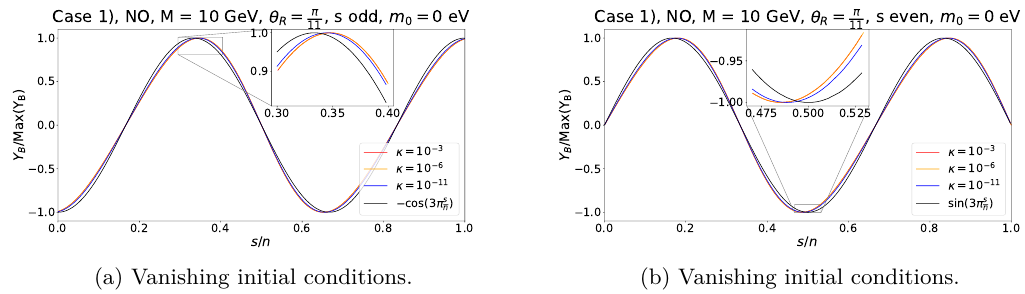
, treated as continuous parameter, for odd (left plot) and n ( s ) as expected from the CP-violating s n is fixed to θ = π and light R R 11